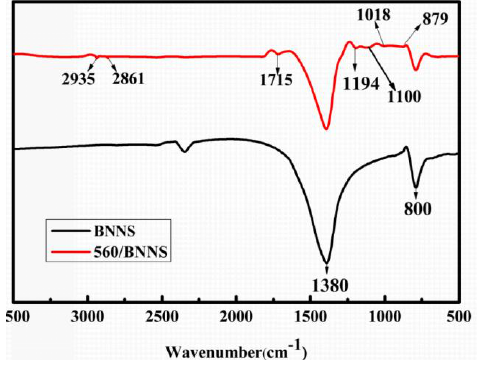
Figure 5. FT-IR result of BNNS and 560/BNNS.